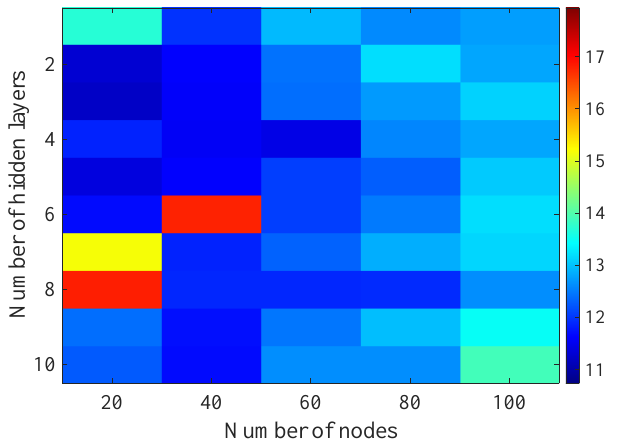
Figure 19. Matrix of the BLER RMSE metric predictions for the radio parameters history window W = 30 in the second stage learning process.